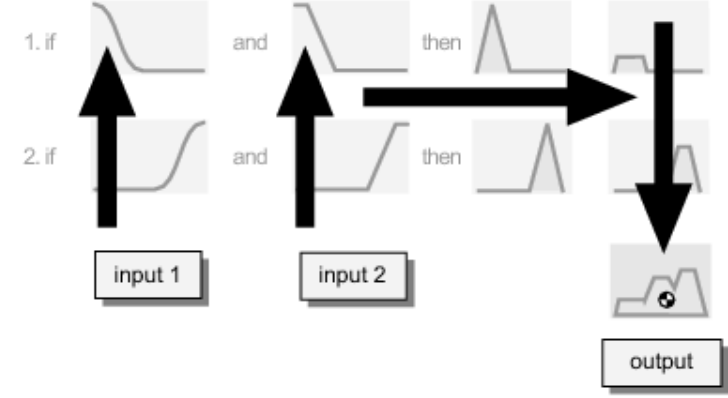
Figure 9. Fuzzy rule-based inference system